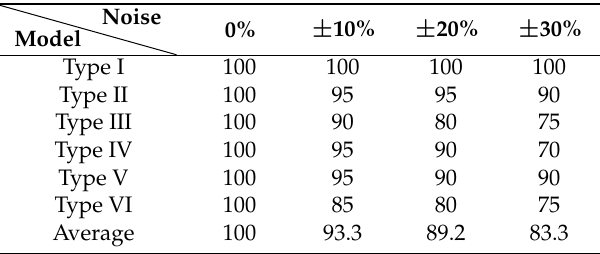
Table 4. Identification results improved by combining IHHT with phase ‐ resolved patterns.